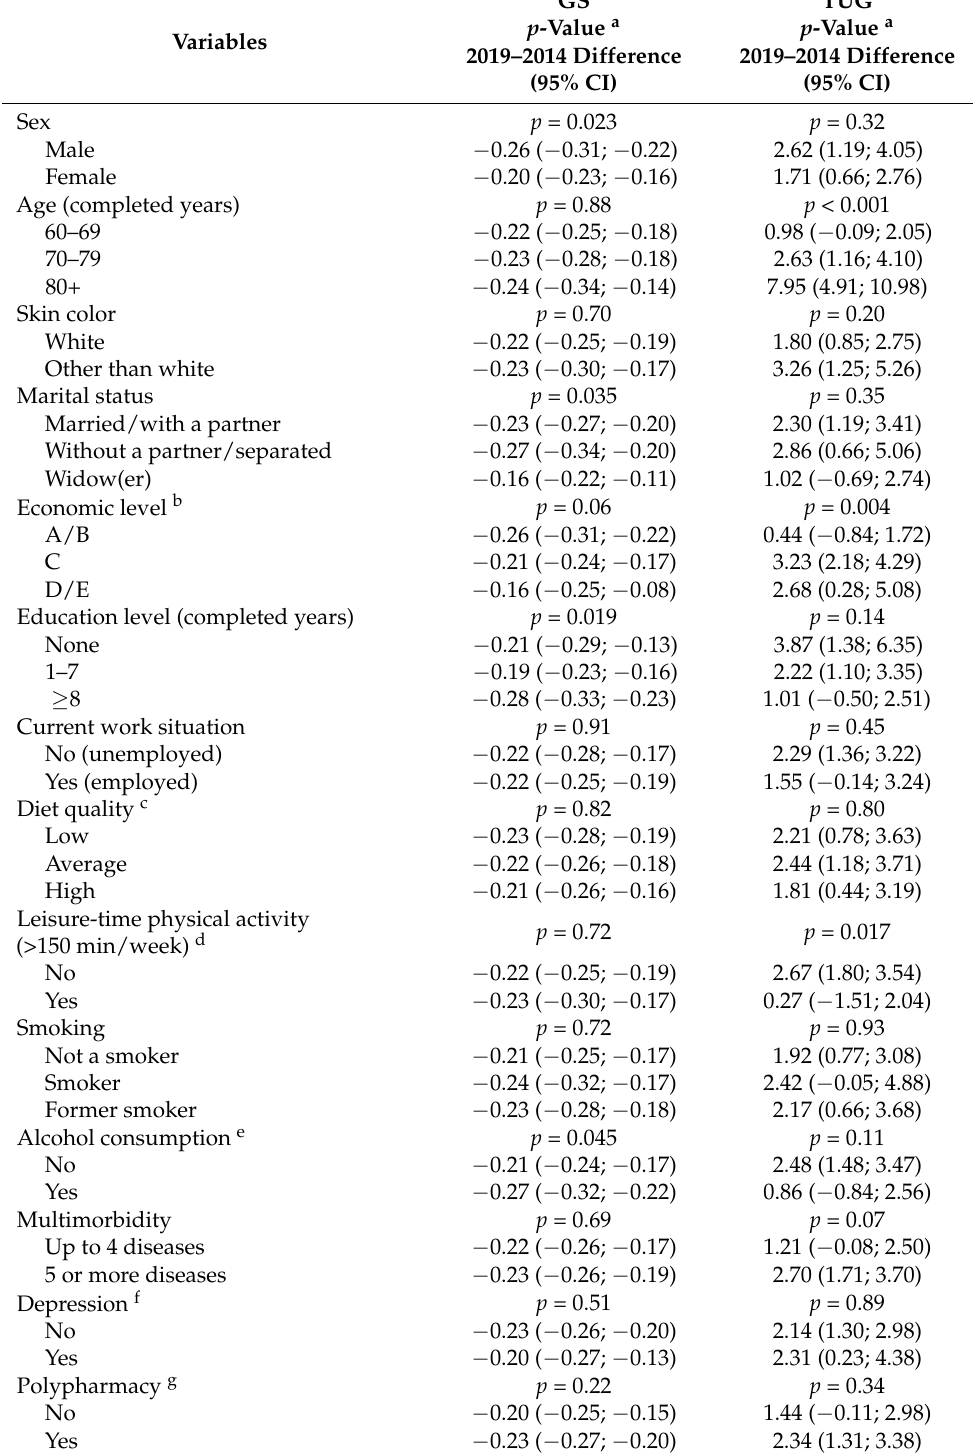
Table 2. Gait Speed (GS) and Timed Up and Go (TUG) differences between the two assessments, according to sociodemographic, behavioral, and health-related variables. n = 476. Pelotas,